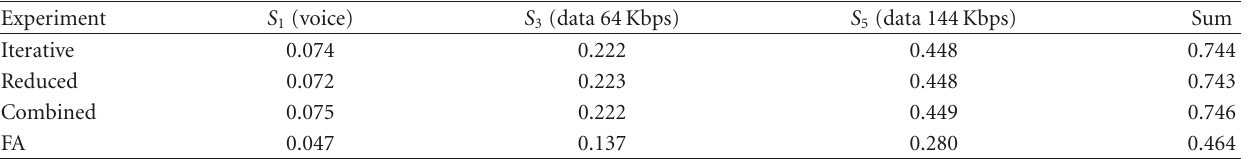
Table 8: Resulting load factors for the di ff erent services.